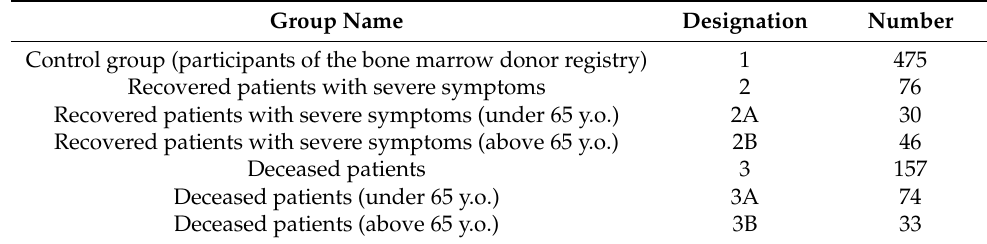
Table 17. List of the groups subjected to the analysis.